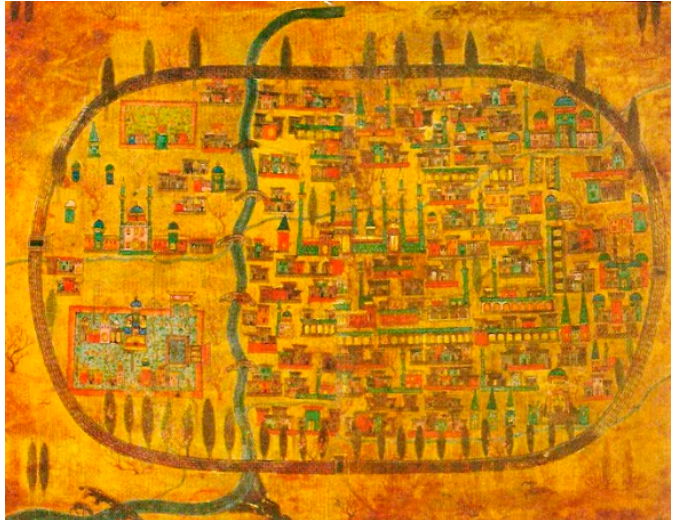
Figure 7. The green system structuring of the Medina of Marrakech. (data source: El Faïz, M. Mar- rakech: An Ecological Miracle and its Wanton Destruction. In: Gardens, City Life and Culture . Conan, M., Whangheng, C.: Gardens, City Life and Culture: Harvard University Press: Scotland, 2008, pp. 193–201).